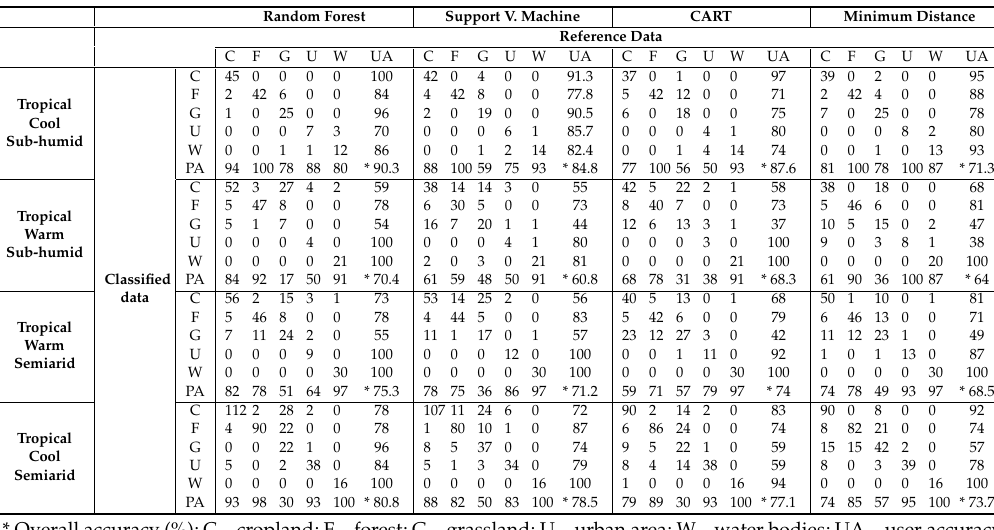
Table 6. Summary of the confusion matrix of land cover maps.